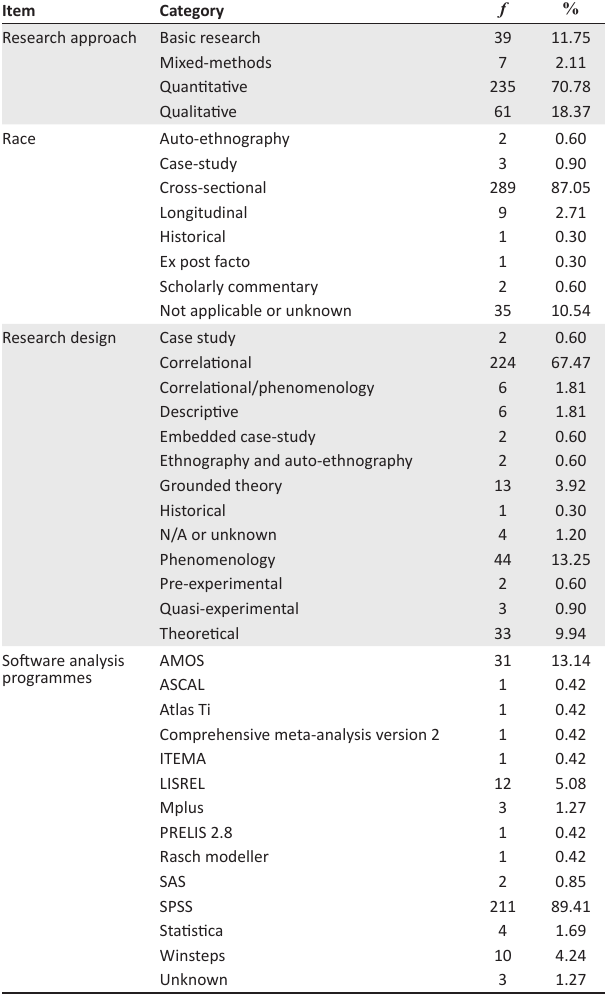
TABLE 6: Research methodology and software